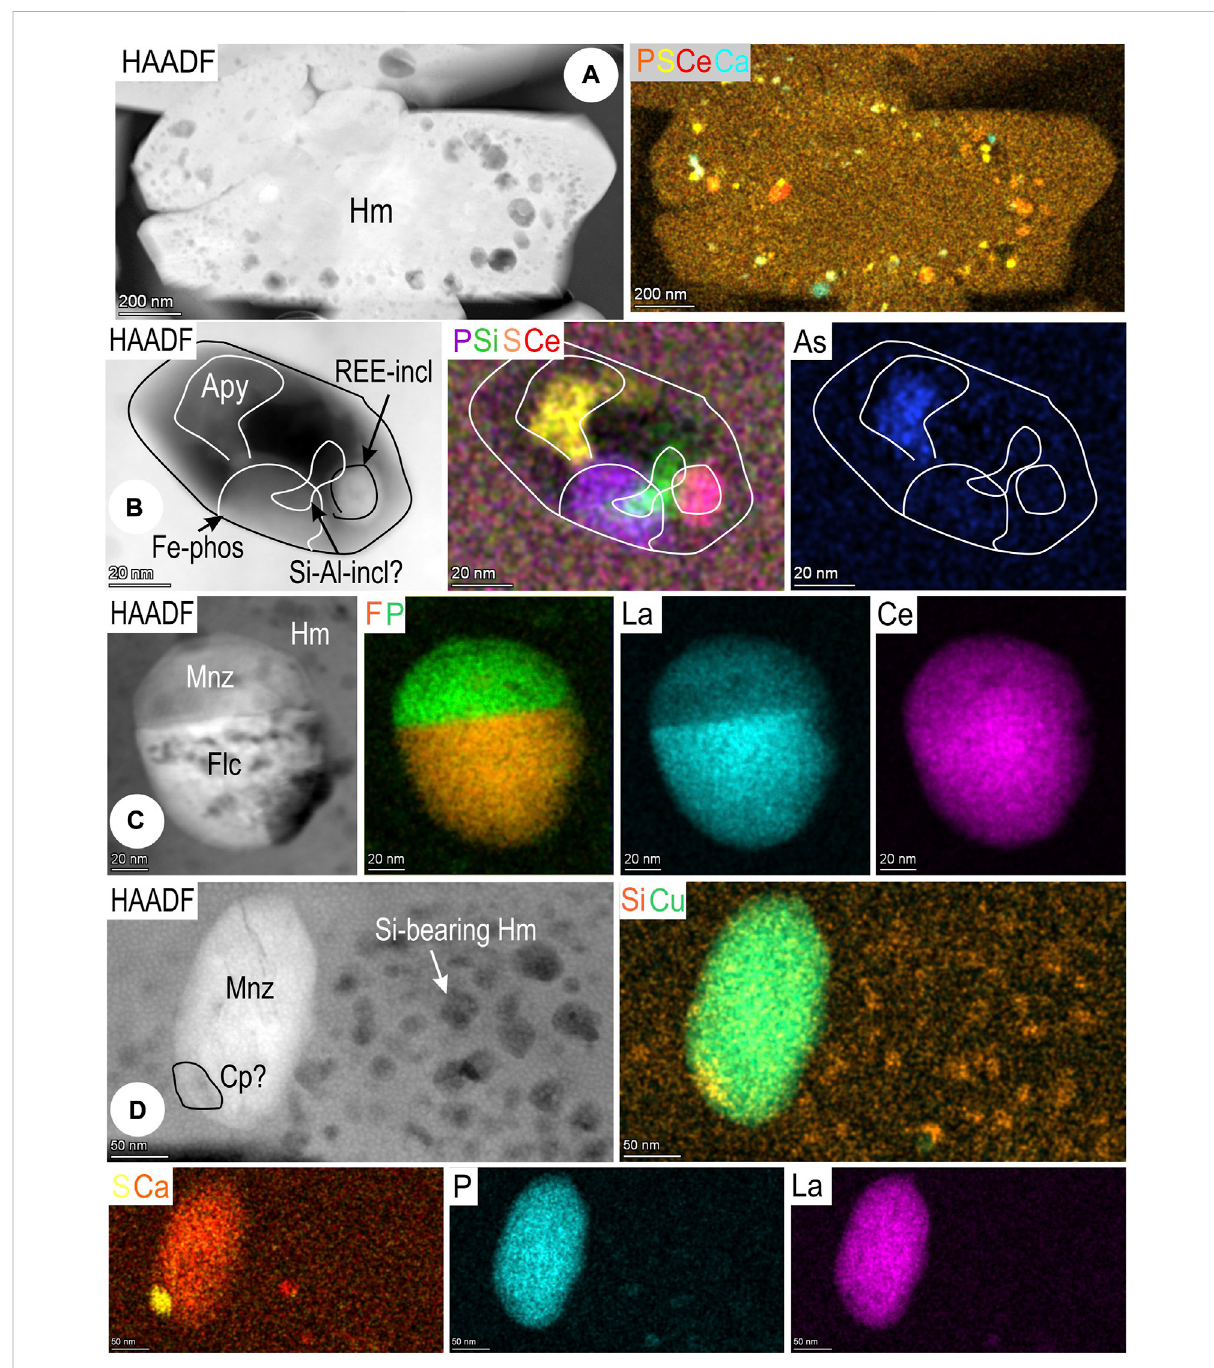
FIGURE 10 Images and STEM EDS element maps of nanoinclusions in hematite from sample 1T (maps 3 – 6; foil Hm#1). (A) Smaller grain of hematite with clustering of NPs, including multiple discrete LREE species, around grain margins. (B) Composite NP containing arsenopyrite (Apy), a REE-mineral (cerianite?), a Si-Al-bearing phase and an unidenti fi ed Fe-phosphate interpreted as an opened fl uid inclusion (C) Binary NP comprising monazite (Mnz)and fl uocerite(Flc).NotedifferencebetweenmapsforLaandCe. (D)